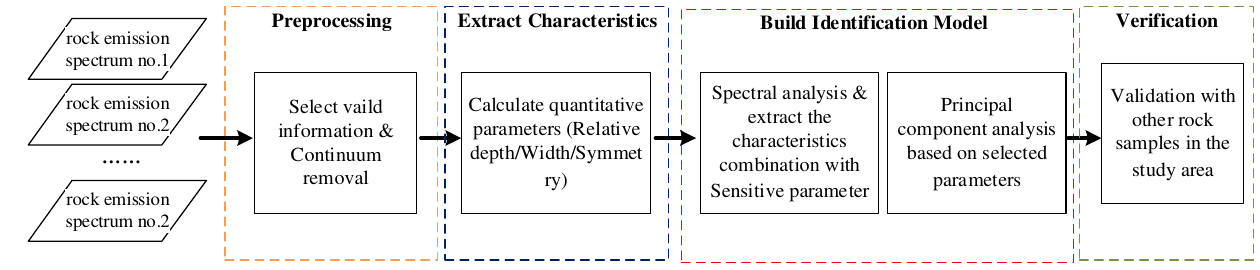
Figure 6. Workflow of model establishment and verification.